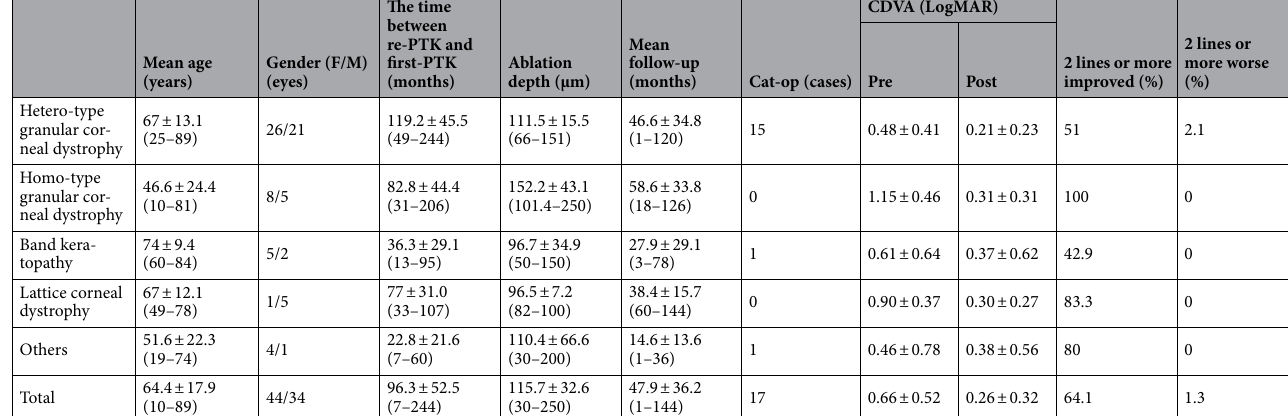
Table 1. Re-Excimer laser phototherapeutic keratectomy: preoperative diagnoses, corrected distance visual acuity and related characteristics. The postoperative CDVA = the best CDVA recorded after PTK. Cat-op = the